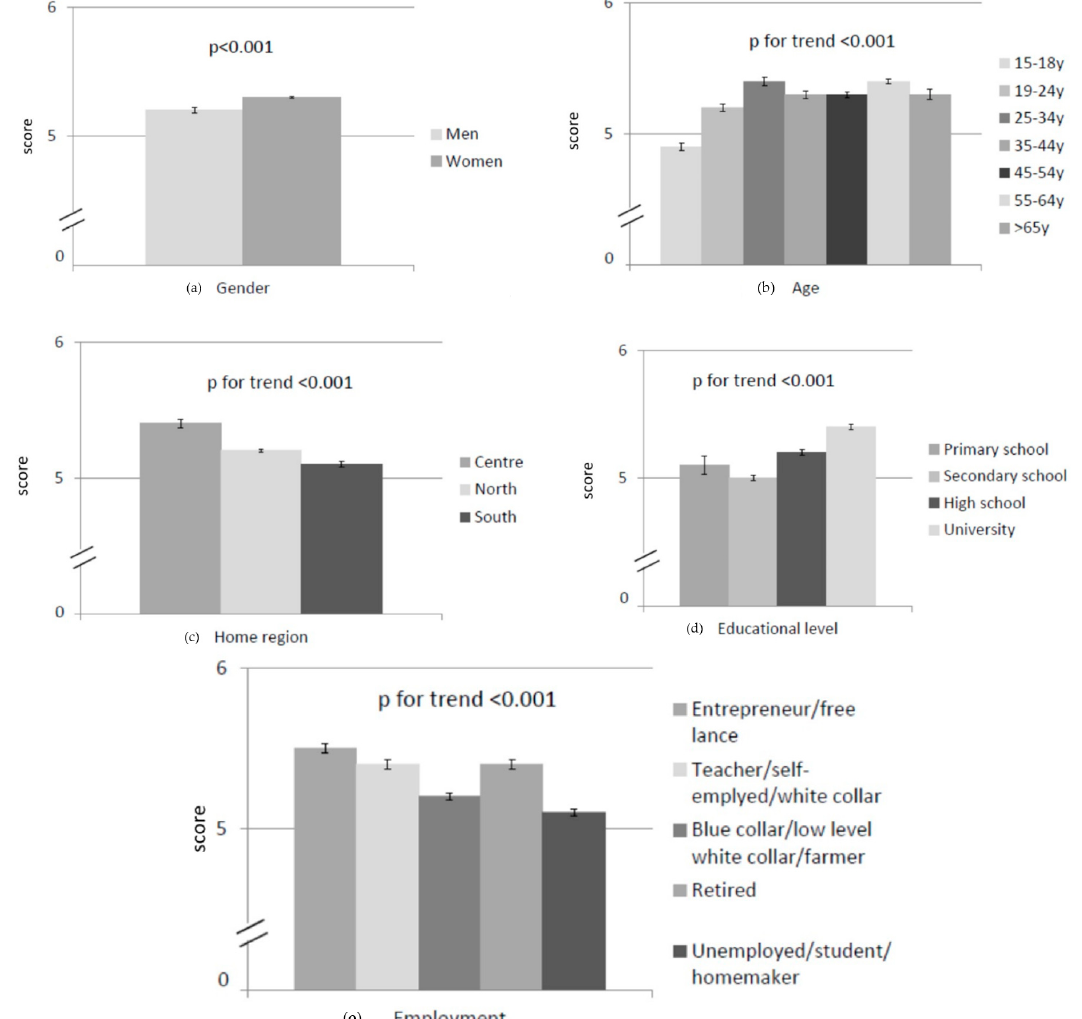
Figure 3. Adherence to the Mediterranean Diet in relation to sociodemographic factors: ( a ) gender; ( b ) age; ( c ) home region; ( d ) educational level; and ( e ) employment. Results are expressed as mean ± standard error ( n = 11,618).